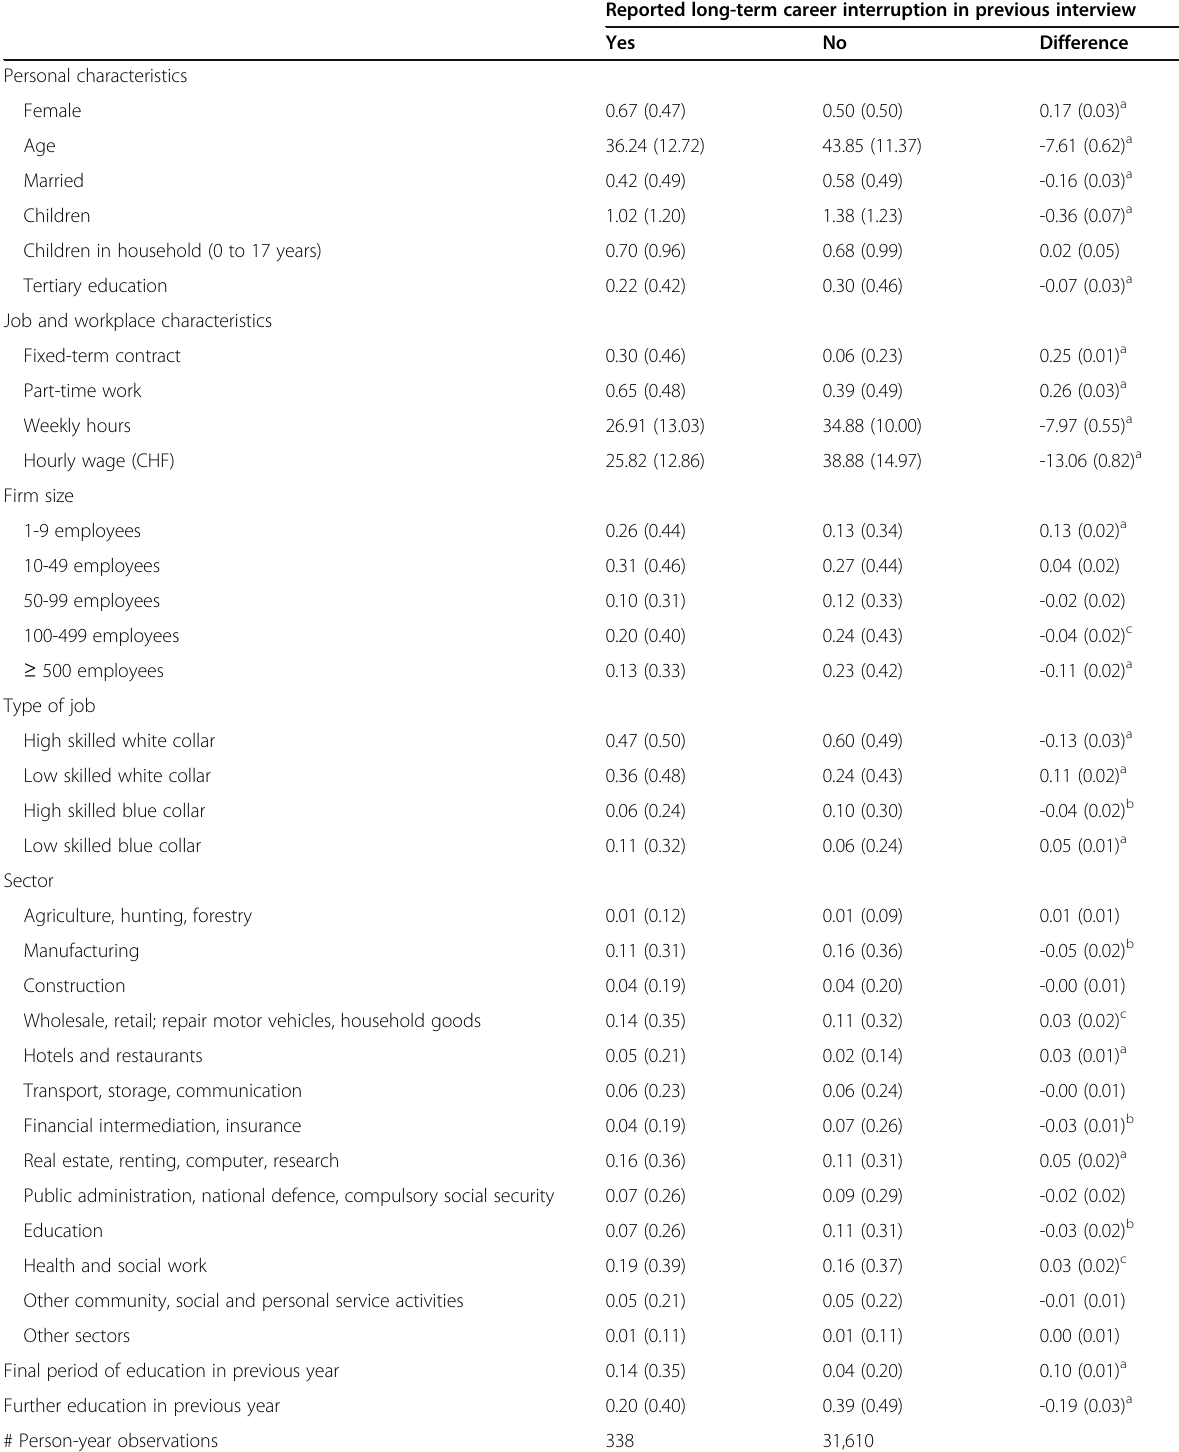
Table 1 Descriptive statistics of employed people by recent labor market history,